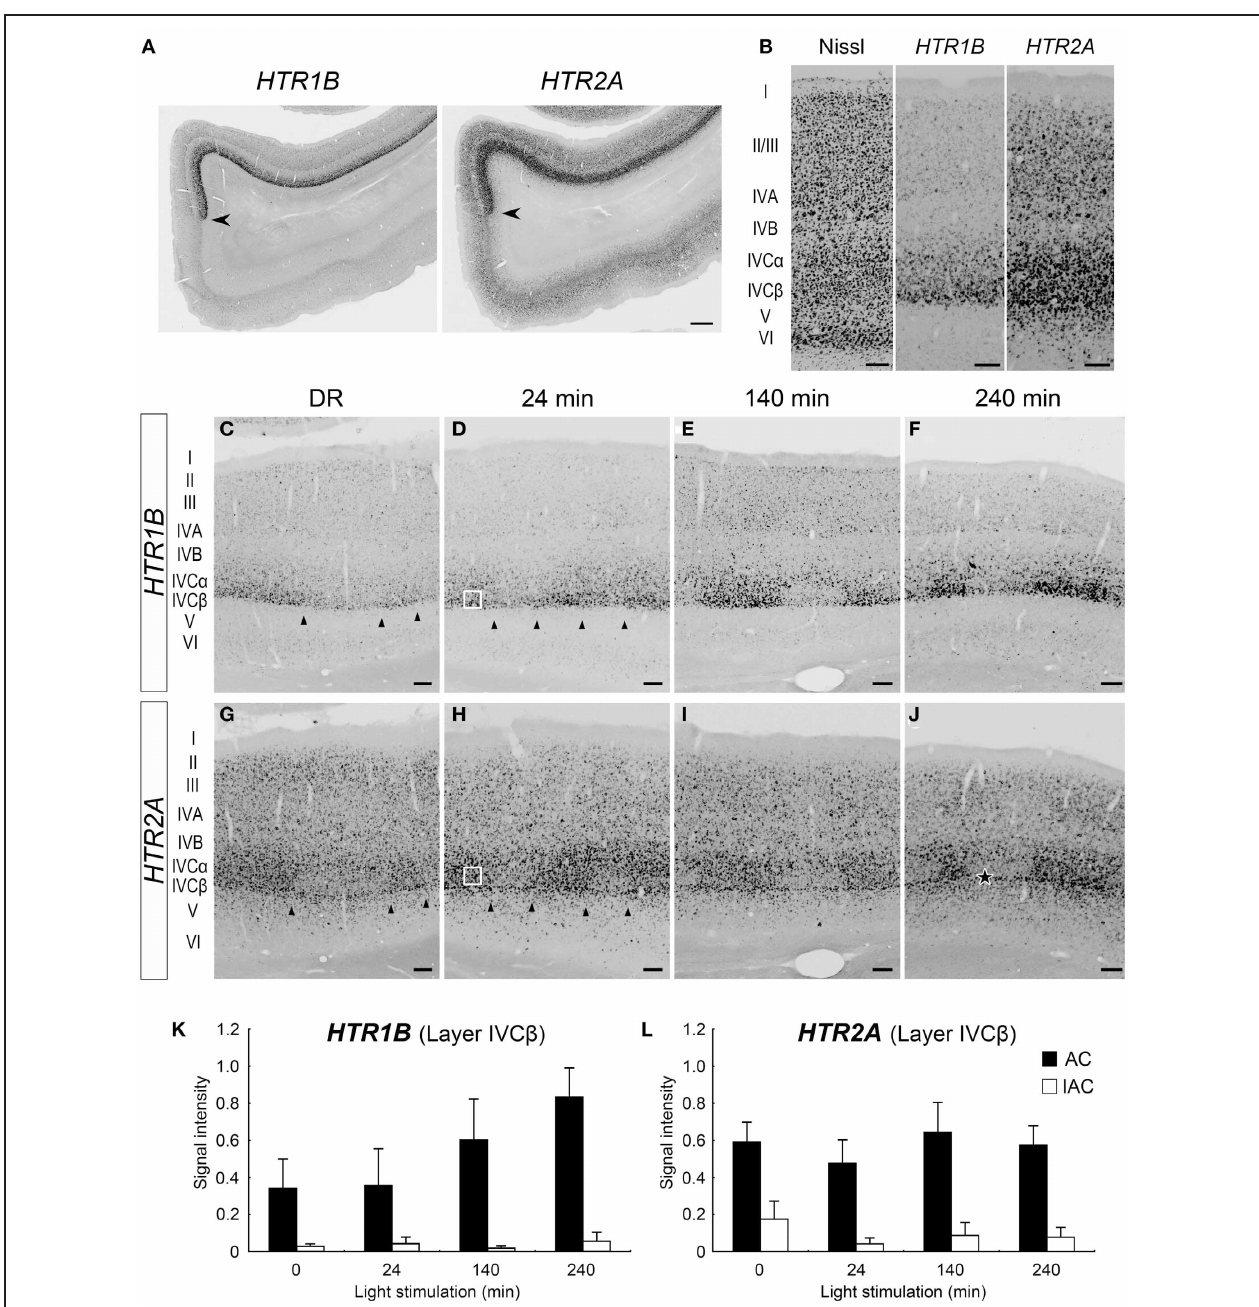
expressed across ODCs. Arrowheads indicate boundaries of ODCs, which were demarcated on the basis of the pattern of ZIF268 mRNA in the adjacent sections. Open squares in panels (D,H) indicate the regions of layer IVC β isolated for quantification analysis as examples. The regions of other time points are also taken at similar layer positions for quantification analysis in (K) and (L) . Scale bars: 100 μ m. (K,L) Quantification of mRNA signal levels of HTR1B (K) and HTR2A (L) in layer IVC β of V1 for each time point. Filled bars, active-eye columns (AC); open bars, inactive-eye columns (IAC). For this calculation, five sections (for DR and 140min) and six sections (for 24 and 240min) were obtained from two or three marmosets in each time point (see Table 1 ). Error bars show